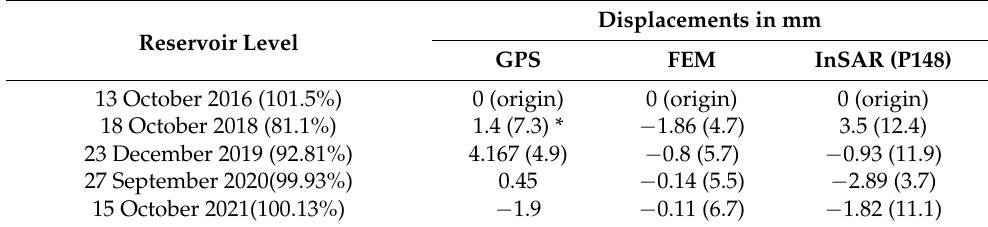
Table 4. Maximum radial displacements at different filling times of the Sanalona dam.